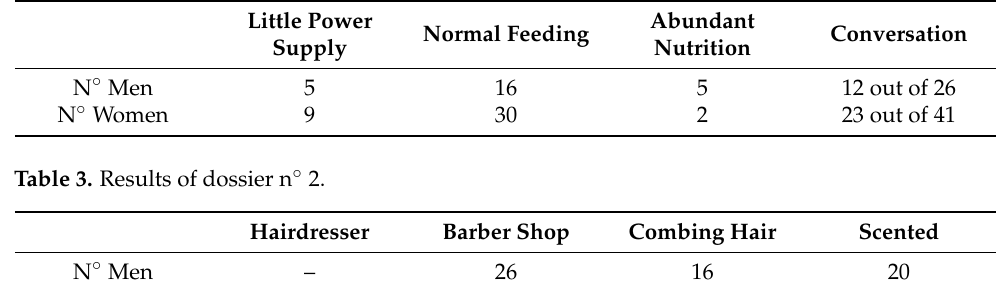
Table 2. Results of dossier n ◦ 1.